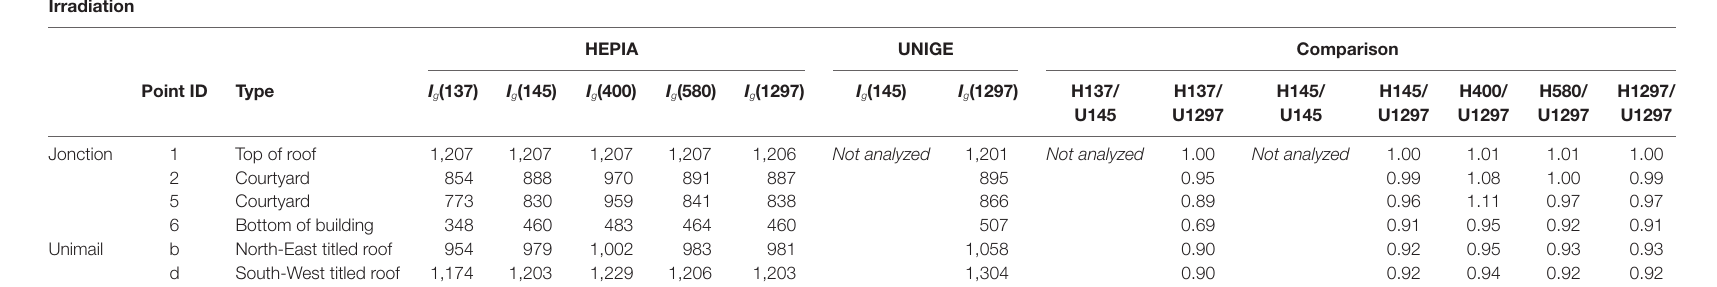
hePIA UNIGe Comparison